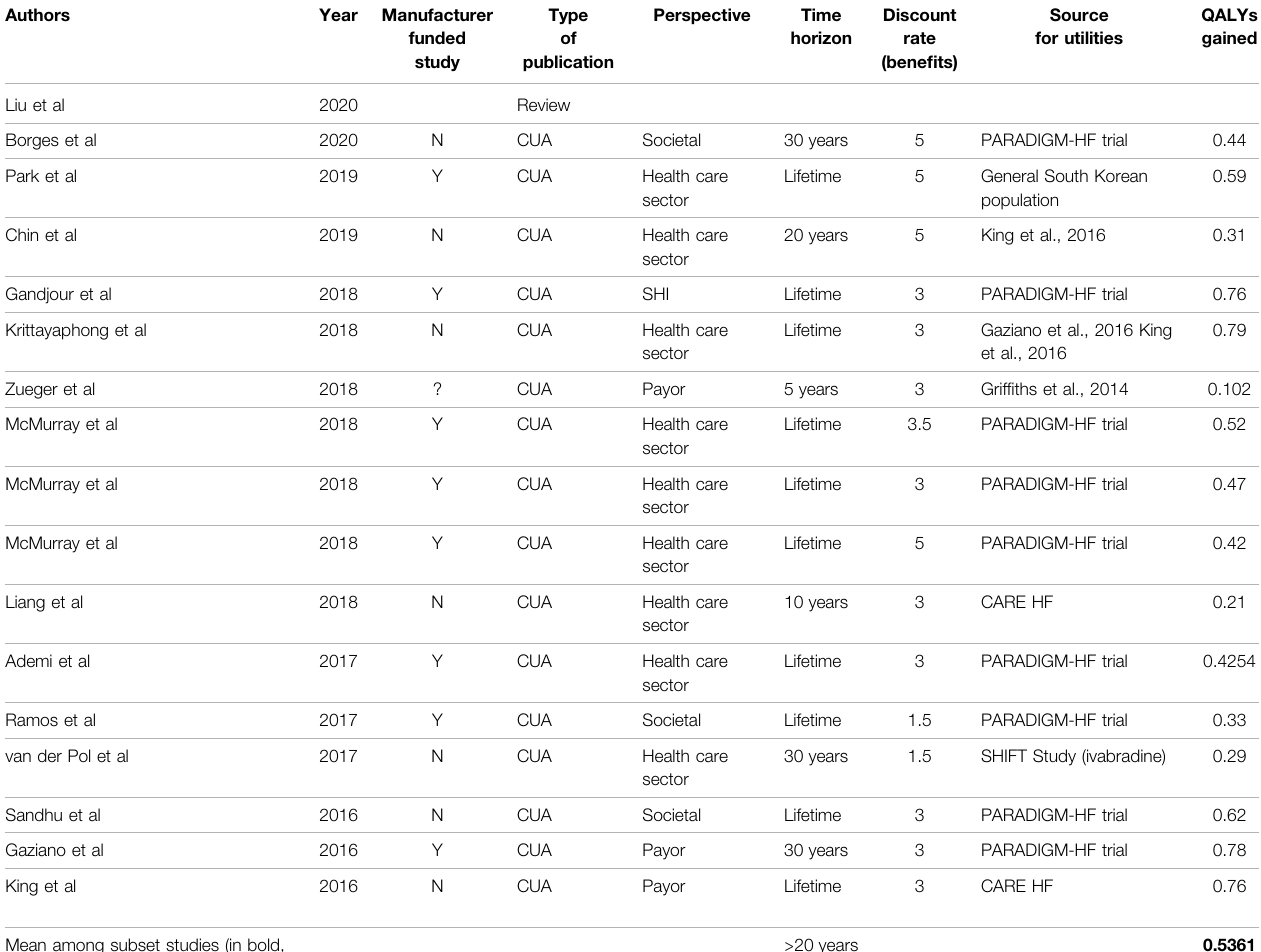
TABLE 2 | List of published sacubitril-valsartan studies reporting QALY